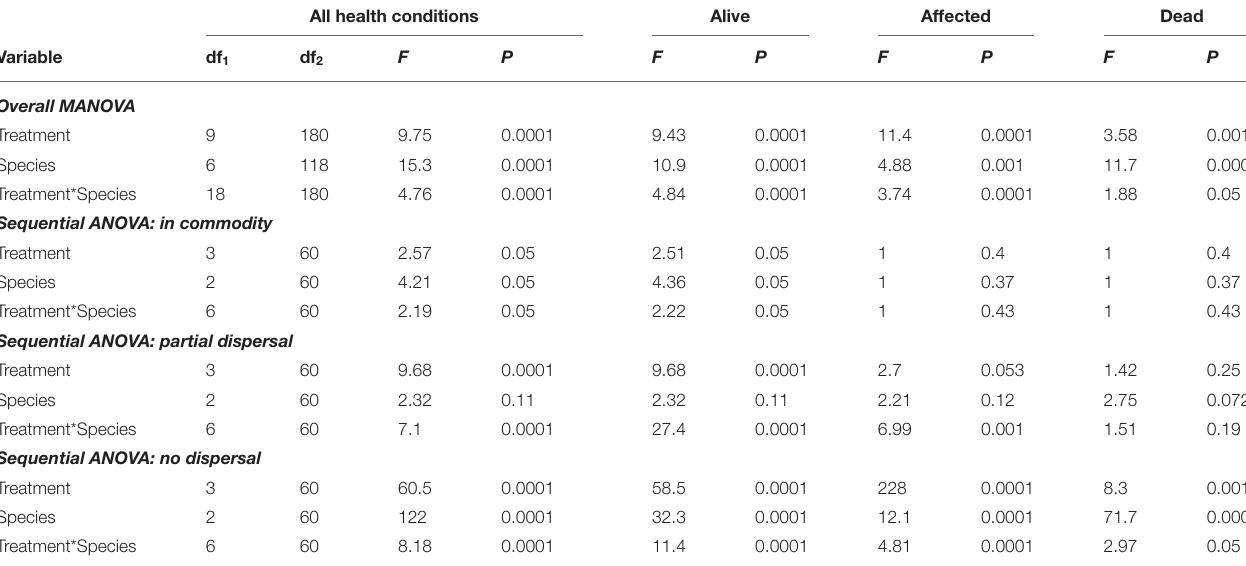
TABLE 4 | Statistical model results for recapture of individuals in the commodity, partially dispersing, and not dispersing in Trial 1 examining efficacy of LLIN deployment method in a pilot-scale warehouse release-recapture assay deployed in 2019 in Manhattan, KS. All health conditions Alive Affected